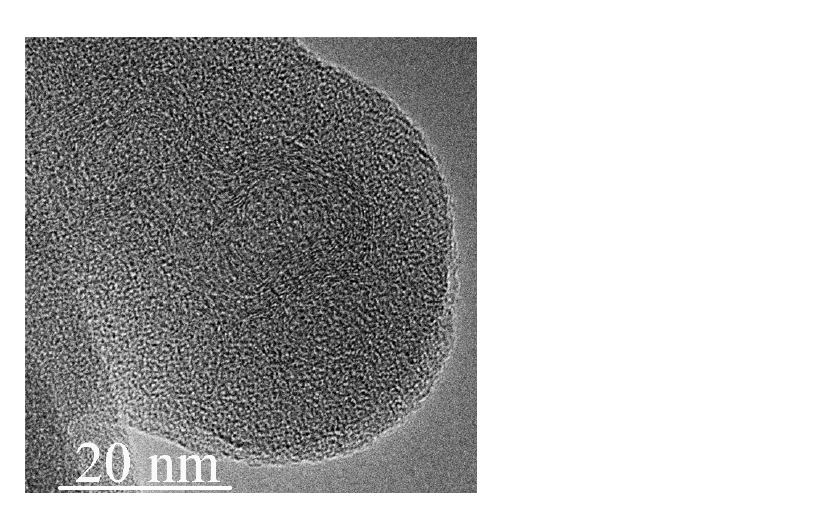
Figure 5. TEM images of different onions ( a , b ), obtained after shear deformations of the g-C3N4 specimen at 70–79 GPa. Onion-like structures are seen in the specimen after shear deformation at pressures of 70–79 GPa (Figure 5). The average size of the onion-like structures is still around 20 nm. However, the nitrogen content drops drastically to 1% (Table 1). These data indicate that sp 3 -bonded carbon nitride cannot be obtained at 70 GPa under heavy shear deformation. Three different types of nonoxidized N atoms can be found in C-N materials [23]: (a) “pyridinic”, (b) “pyrrolic”, and (c) “graphitic” nitrogen, with binding energies of ≈ 399.0, ≈ 400.3, and ≈ 401–403 eV, respectively. As follows from the EELS spectra (Figure 6), “gra- phitic” nitrogen is detected in the C-N phases before and after shear deformation. The presence of strong C-K and N-K π * peaks indicates that the starting g-C 3 N 4 phase is pref- erentially sp 2 bonded [24,25]. To estimate the concentration of sp 2 bonds in the carbon